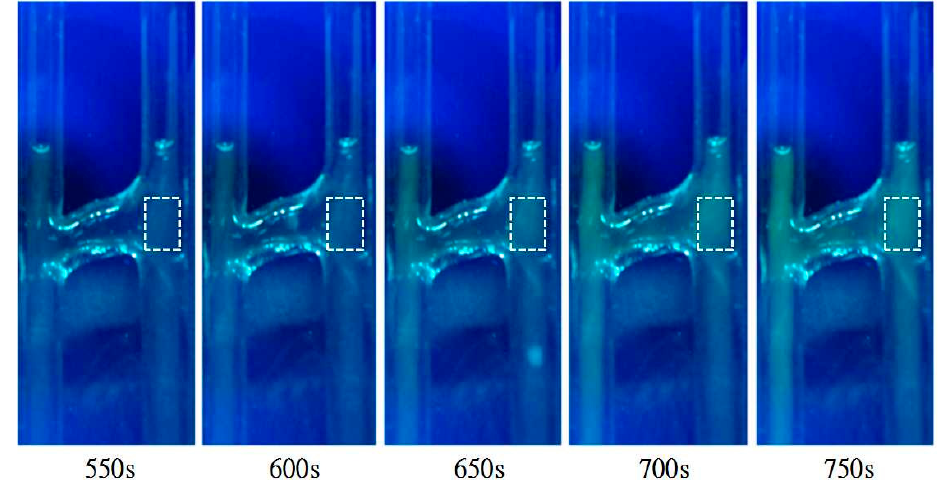
Figure 4. Fluorescence recording during the clcPCR reaction and only the fluorescent image from 550 to 750 s is shown (the initial DNA concentration: 6 × 10 5 copies/tube). The dotted line frame is the area of fluorescent analysis.